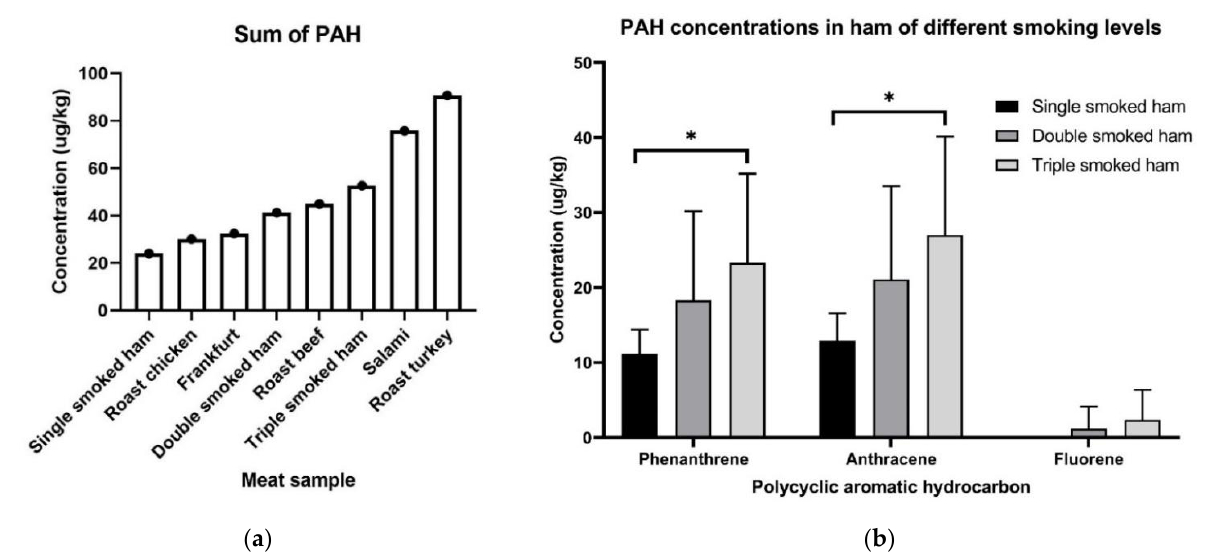
Figure 1. Graph ( a ) shows the total PAH levels detected in each meat sample of single-smoked ham containing the least PAH content and roast turkey having the highest total PAH while; ( b ) specifically shows that triple-smoked ham has significantly higher concentrations of phenanthrene and anthracene than single-smoked ham. * = p < 0.05.